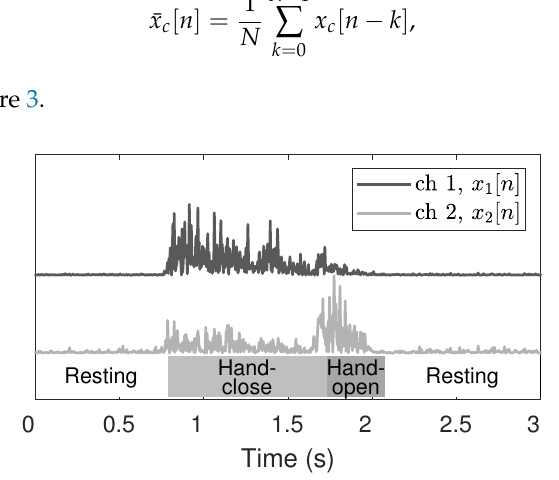
Figure 2. Pre-processed data and activation state related to muscle state.